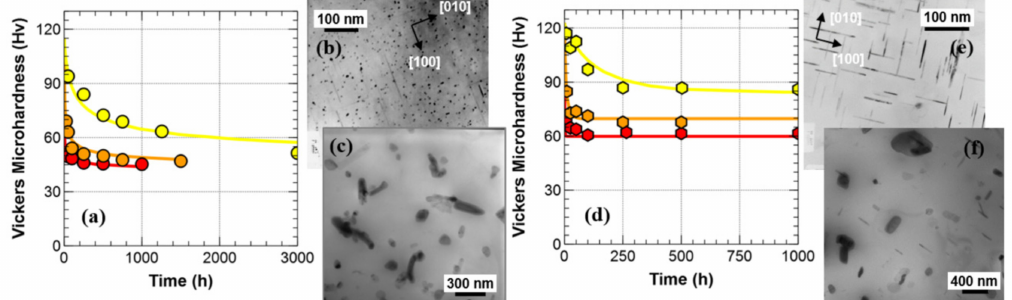
Figure 3. Alloy AlSi7Cu0.5Mg0.3-T7: ( a ) Microhardness evolution with heat treatment time and temperature; ( b ) TEM dark field image of semi-coherent precipitates in initial condition, negative contrast (both image plane and thin foil plane normal directions close to [001] (Al) zone axis); ( c ) TEM bright field image of incoherent precipitates in over-aged condition. Alloy AlSi7Cu3.5Mg0.1 T7: ( d ) Microhardness evolution with heat treatment time and temperature; ( e ) TEM dark field image of semi-coherent precipitates in initial condition, negative contrast (both image plane and thin foil plane normal directions close to [001] (Al) zone axis); ( f ) TEM bright field image of stable precipitates in over-aged condition treated at 300 ◦